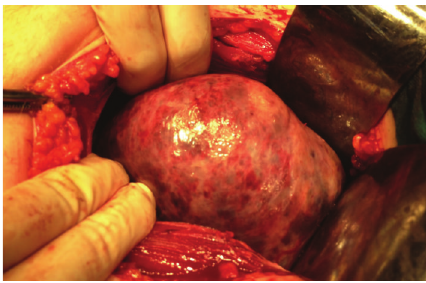
Figure 1: Intra-operative view of the ovarian torsion with necrosis containing dermoid